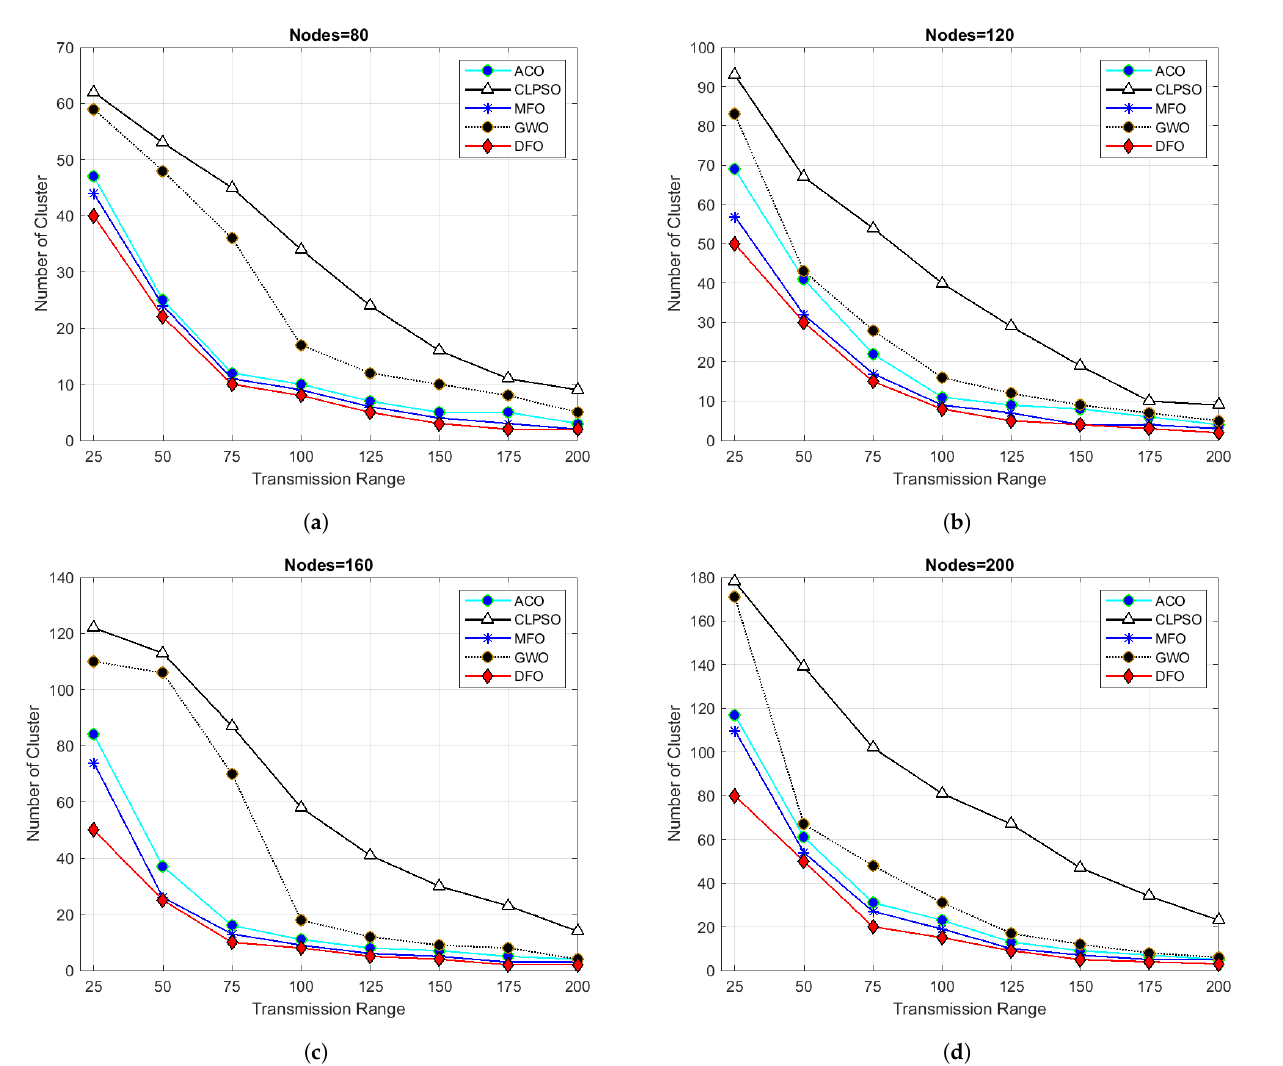
Figure 8. Grid size 500 m × 500 m and transmission range from 25 to 200.